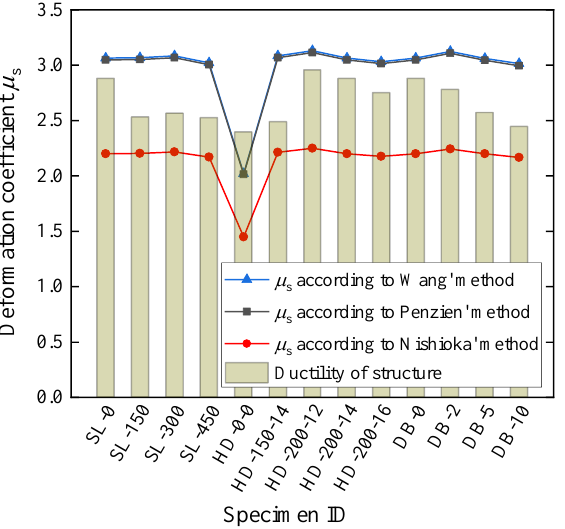
Figure 16. Seismic performance evaluation considering soil – structure interaction.